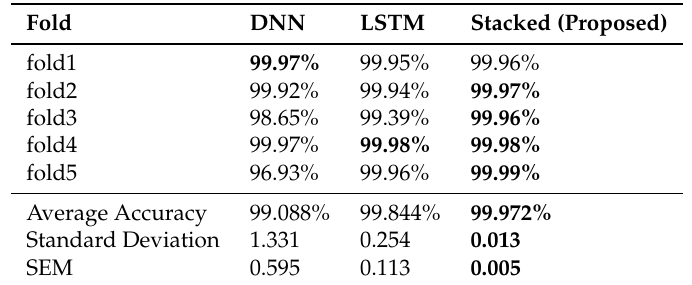
Table 1. Results of classifiers’ performance in terms of 5-fold cross-validation; best results are indicated with bold. Fold